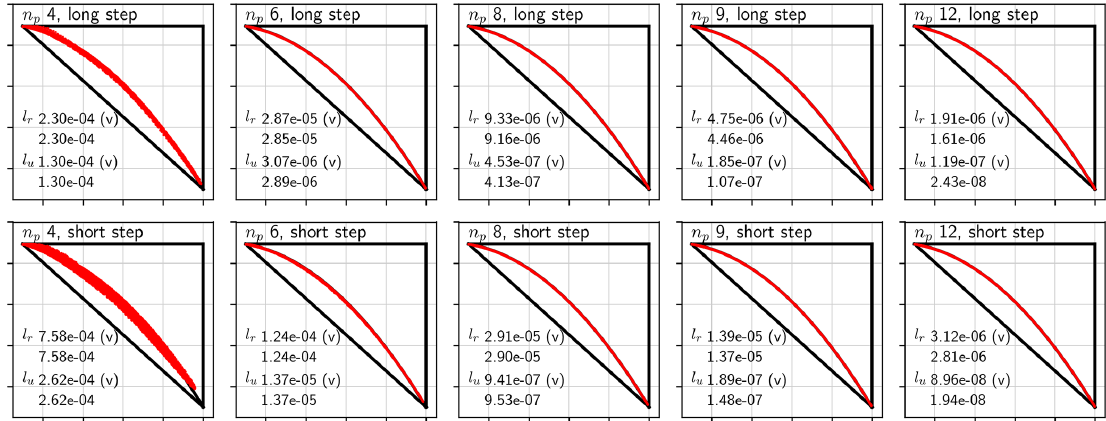
Figure 12. Same as Fig. 11 but with dynamics-grid resolution 0 . 75 ◦